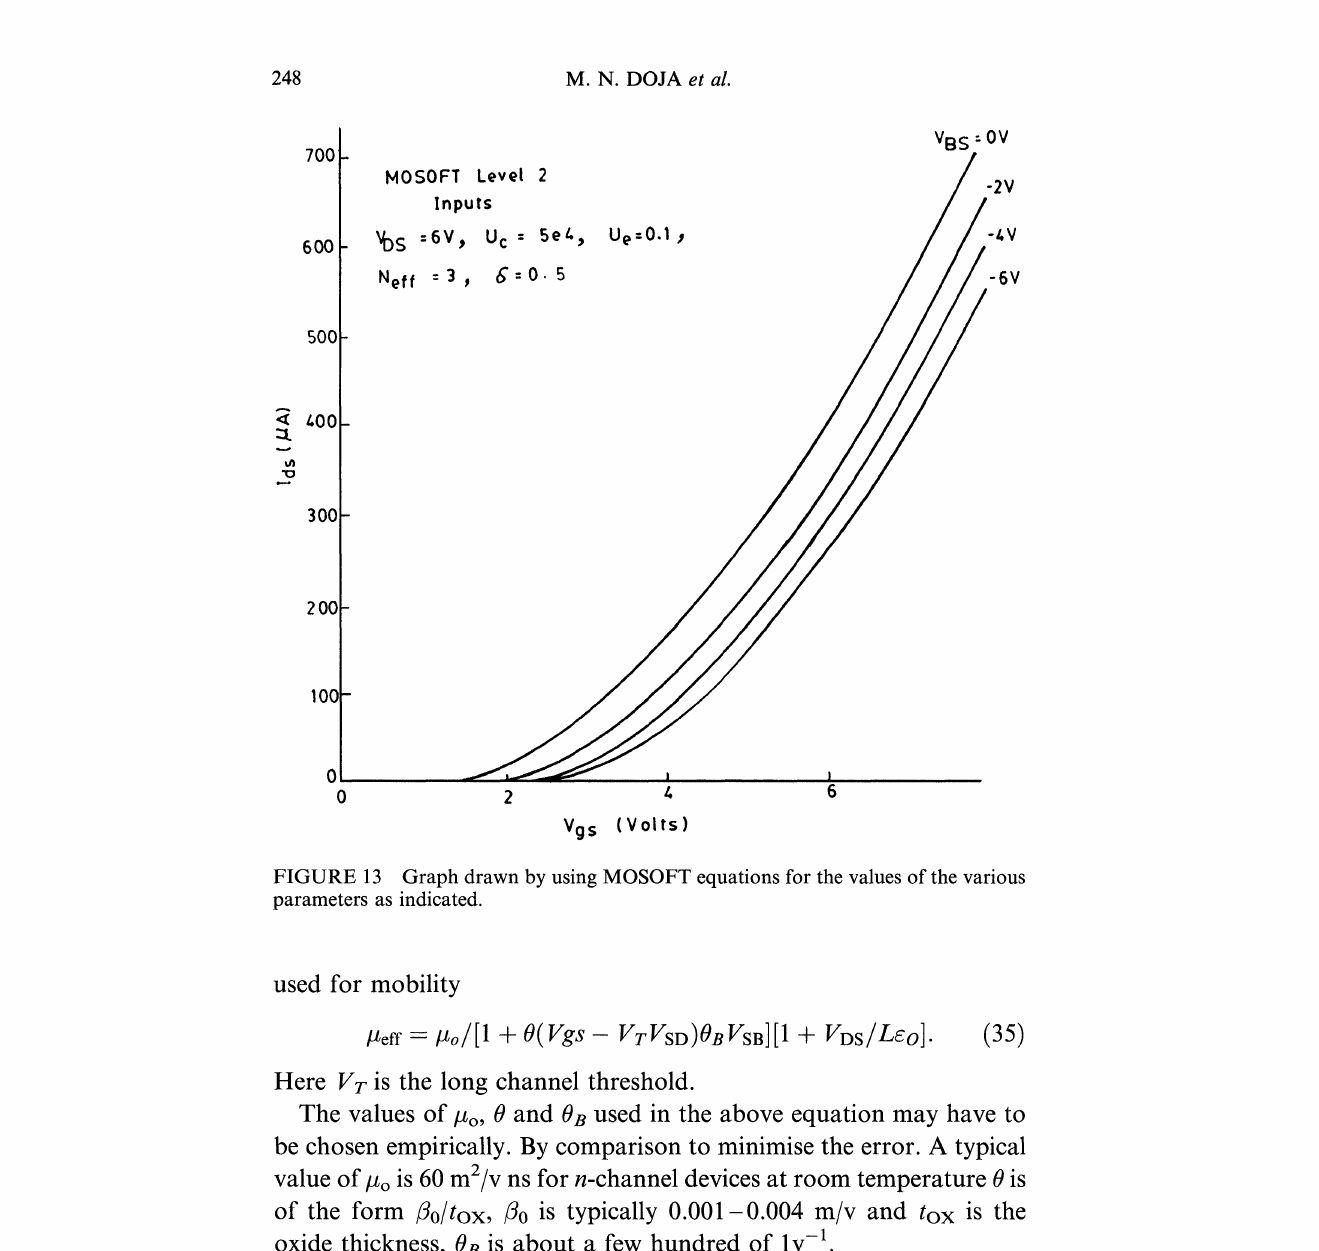
FIGURE 13 Graph drawn by using MOSOFT equations for the values of the various parameters as